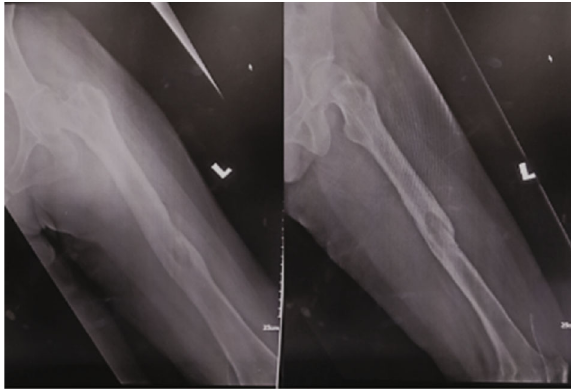
Figure 4: X-rays of left femur post K-nail